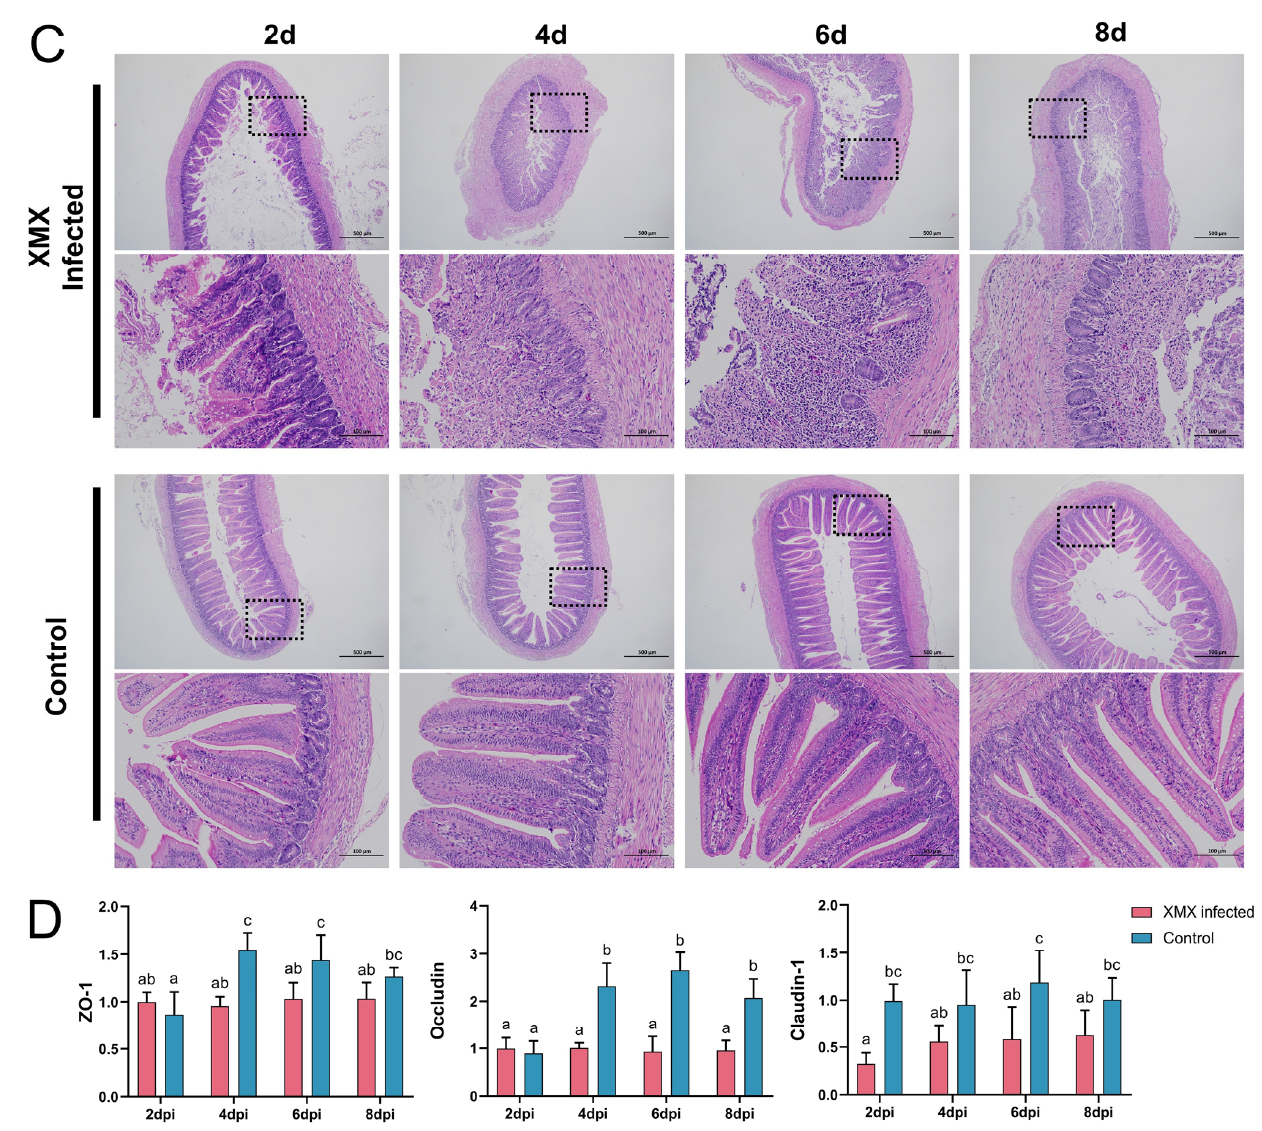
Figure 1. Influence of XMX infection on the ileal epithelial structure. ( A ) Schematic diagram of XMX infection and animal operations; ( B ) Viral load in the ileum; ( C ) Hematoxylin and eosin staining shows the ileal histological features in the XMX infection and control groups; ( D ) qRT-PCR was used to detect the gene expression of ZO-1 , Occludin and Claudin-1 in the ileum. Different letters indicate significant differences.